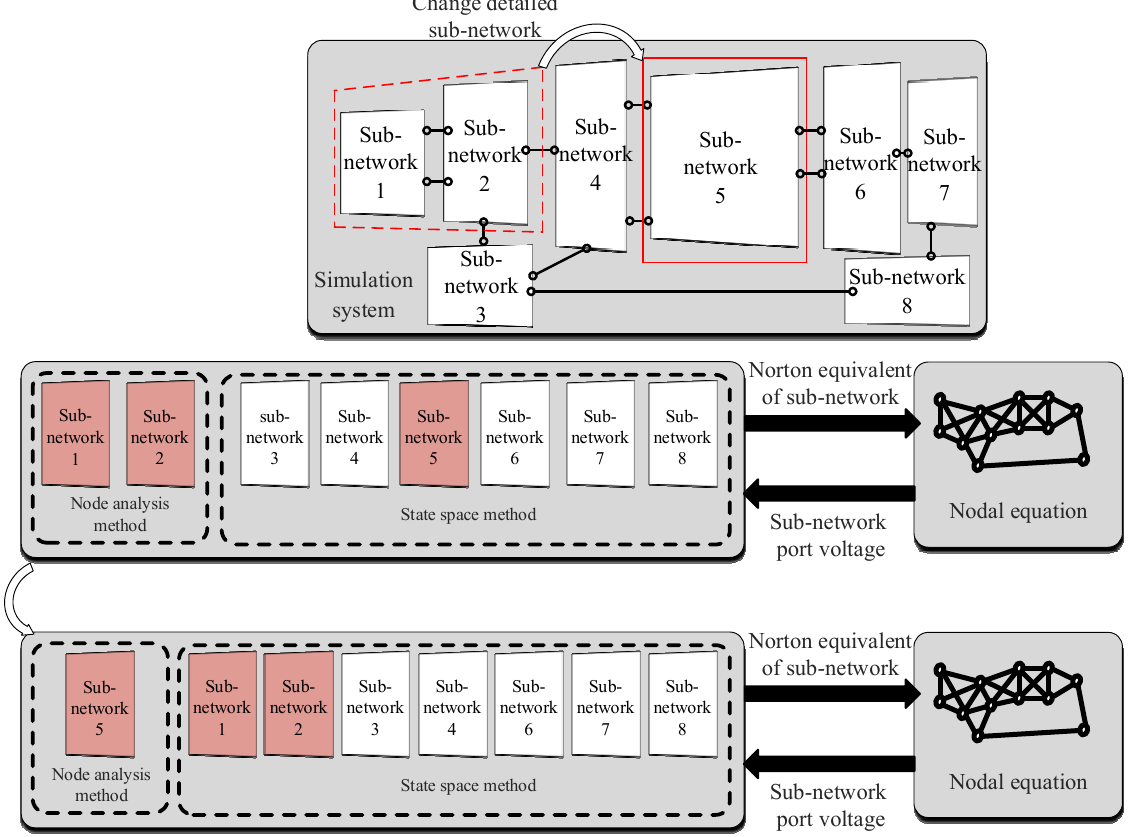
Figure 2. Framework of variable detail sub-network SSN method.